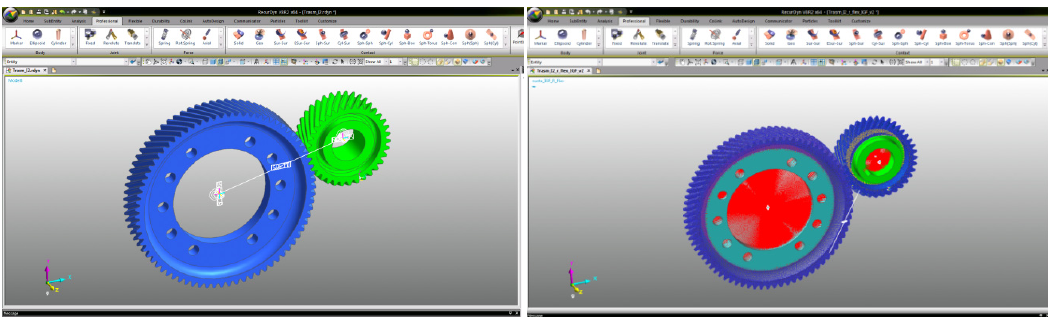
Figure 2: Multibody automotive transmission system, full-rigid on the left and rigid-flexible on the right. G EARS INTERNAL DYNAMIC